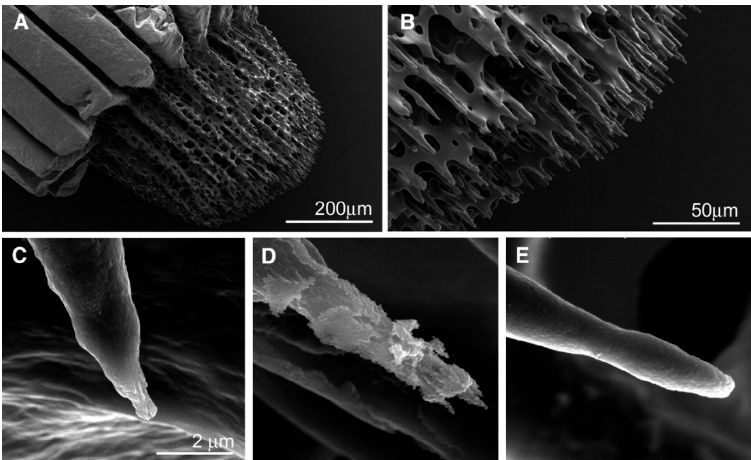
Figure 3. Scanning electron micrographs of regenerating sea urchin spines. ( A ) Five-day-old regenerated spine growing on the original broken spine. ( B ) Higher magnification view of the tip of the new growth, showing the typical stereom structure and the protruding newly formed microspines. ( C ) One microspine formed after 4 days of regeneration, observed fresh. ( D ) Four-day-old microspine, etched in water while fresh. ( E ) Four-day-old microspine, etched in water 1 month after regeneration. The newly formed tip showing the typical stereo structure of spines. Further characterization indicated that the minerals removed from fresh regenerated spines were amorphous calcium carbonate. Reproduced with permission from the American Association for the Advancement of Science in Reference [36].